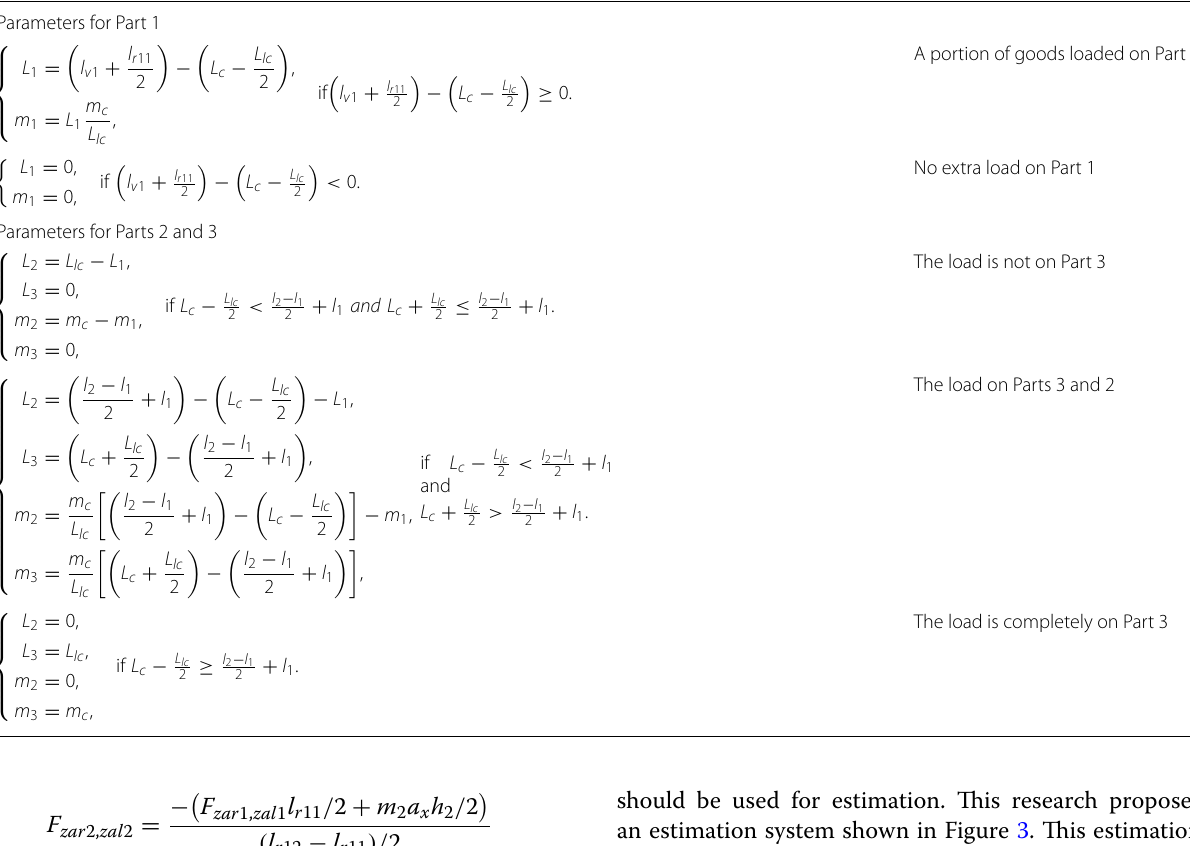
length of goods in Part 1, m i i =